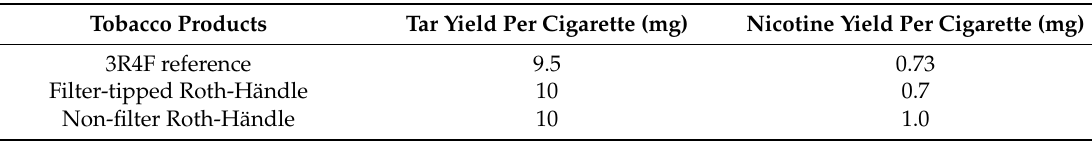
Table 1. Tar yield and nicotine yield for the 3R4F reference cigarettes, filter-tipped Roth-Händle and non-filter